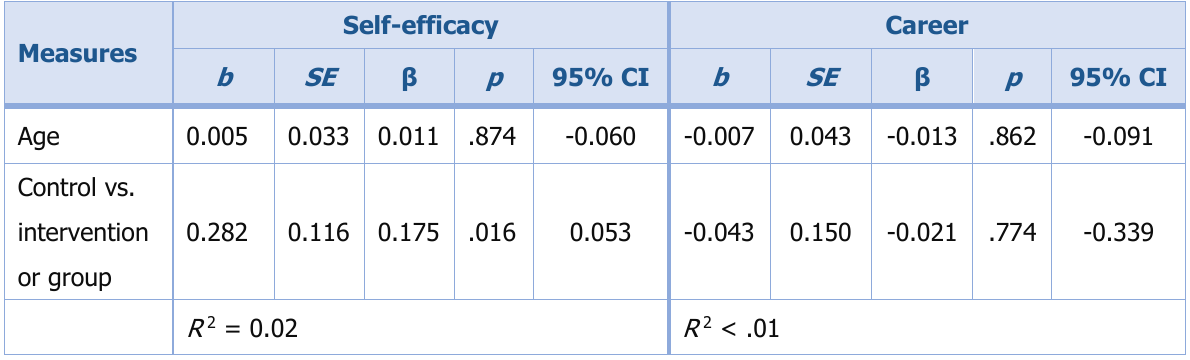
Table 3. Linear Regression MIS Self-Efficacy and Careers Between Groups (Controlling for Age)